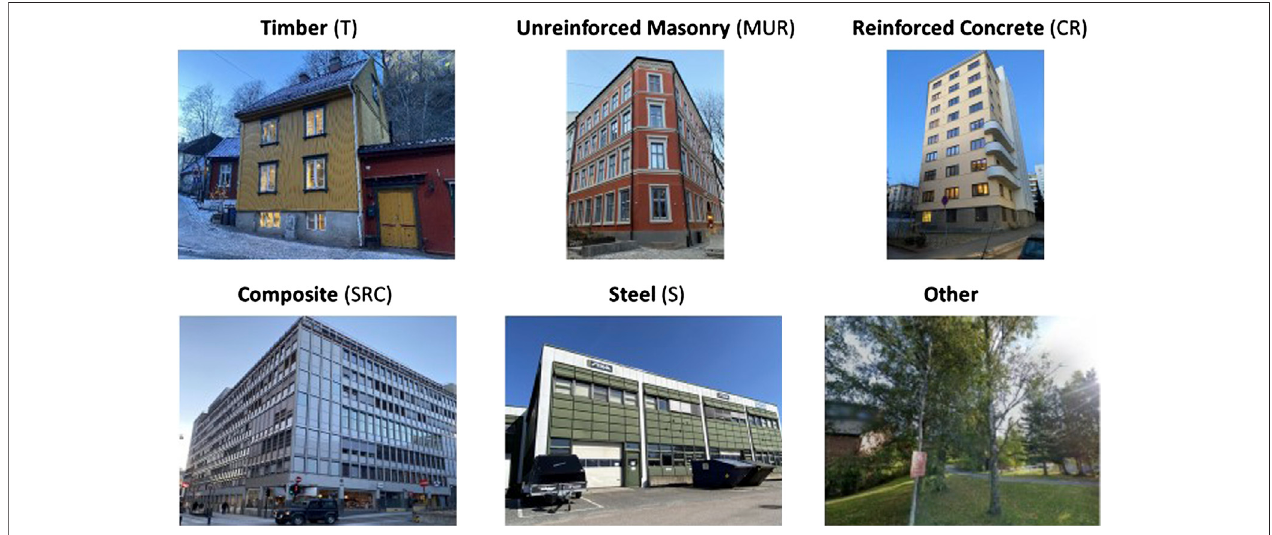
FIGURE 4 | Building typologies for the building stock in Oslo: timber (T), unreinforced masonry (MUR), reinforced concrete (CR), composite (SRC), steel (S) and other.